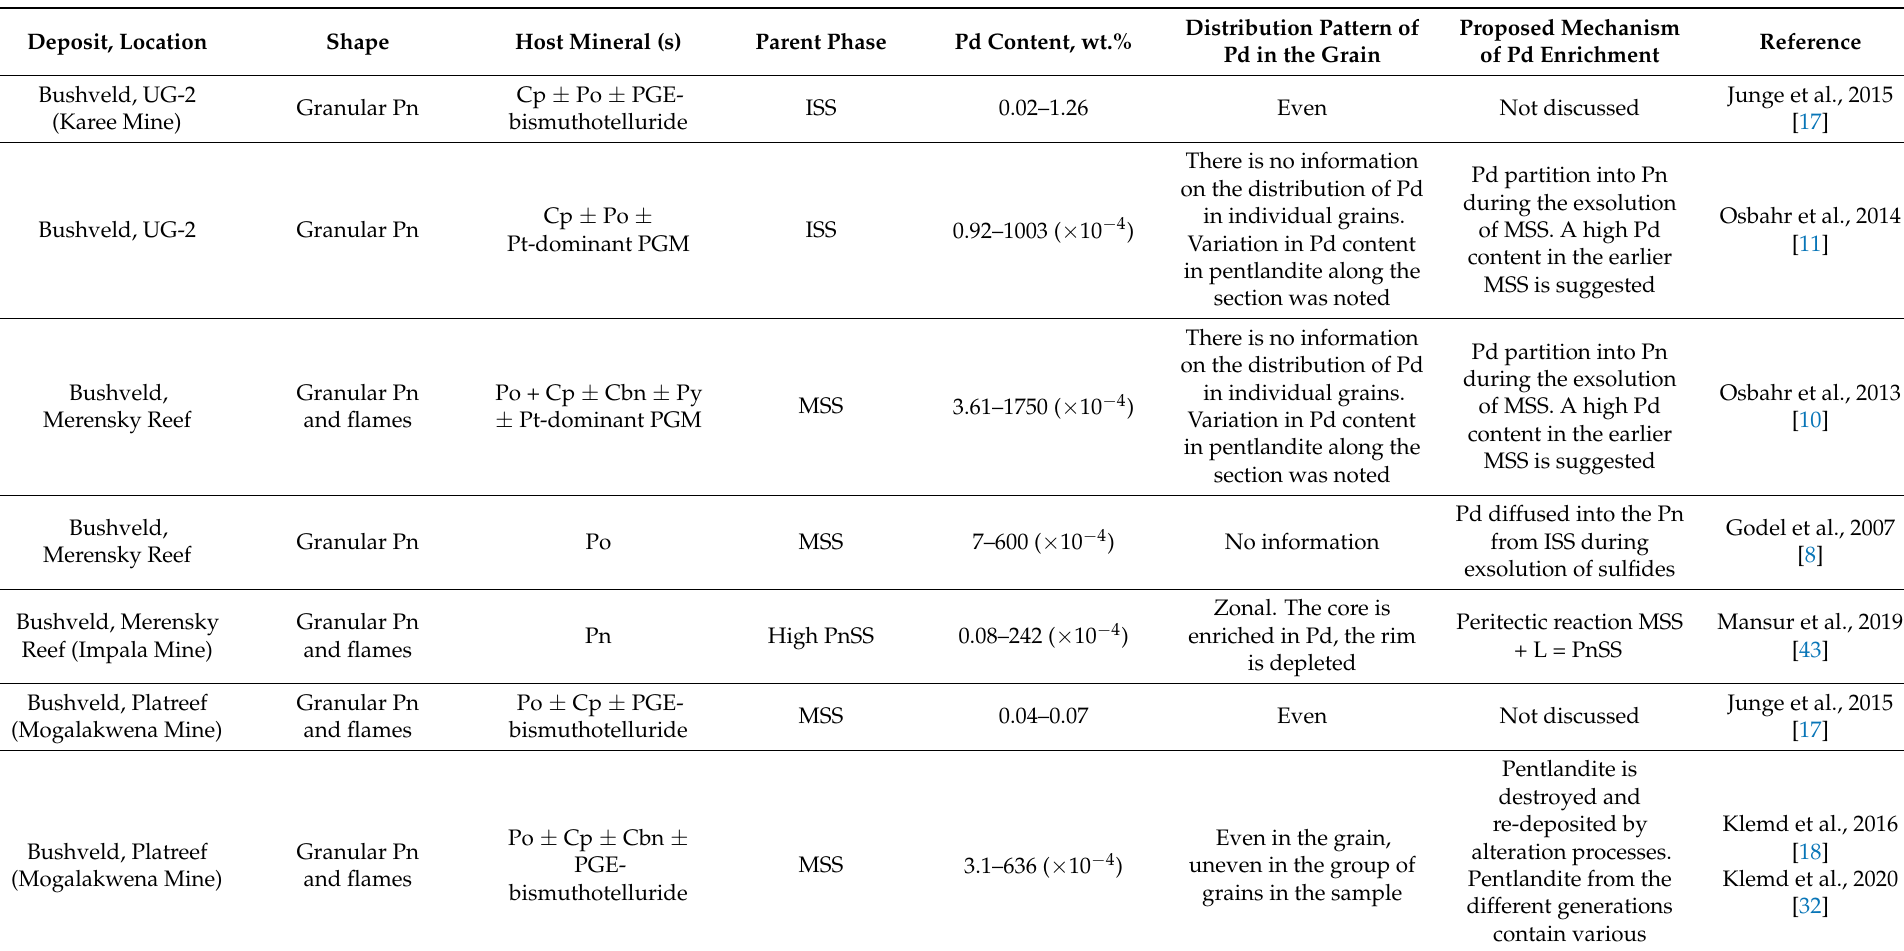
Table 7. Summary of Pd-bearing pentlandites from various